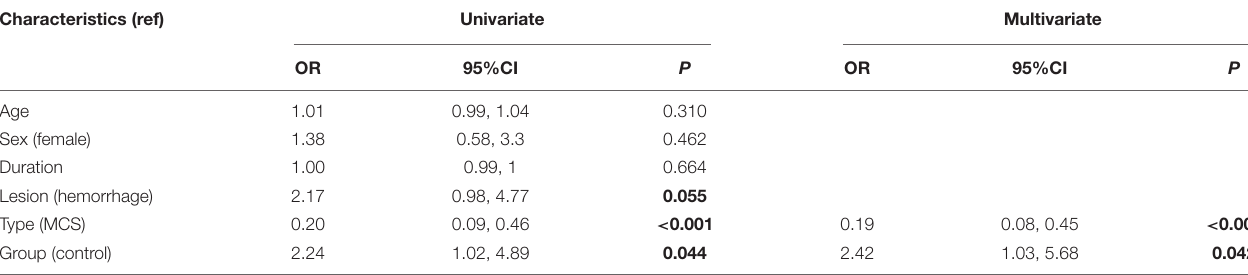
TABLE 5 | Logistic regression analysis based on mGOS improvement.